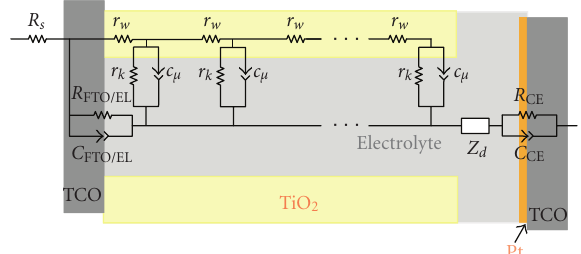
Figure 5: Transmission line model used to fit the EIS experimental